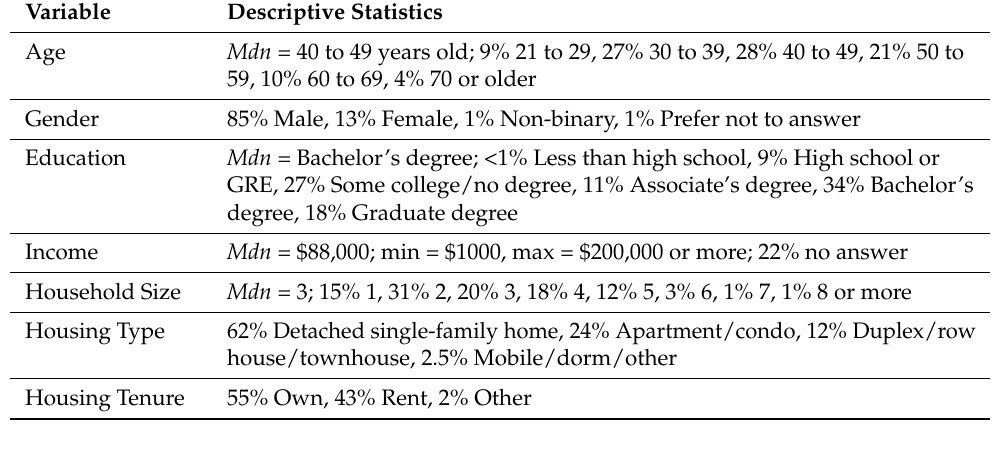
Table 2. TNC-PEV Driver Characteristics.